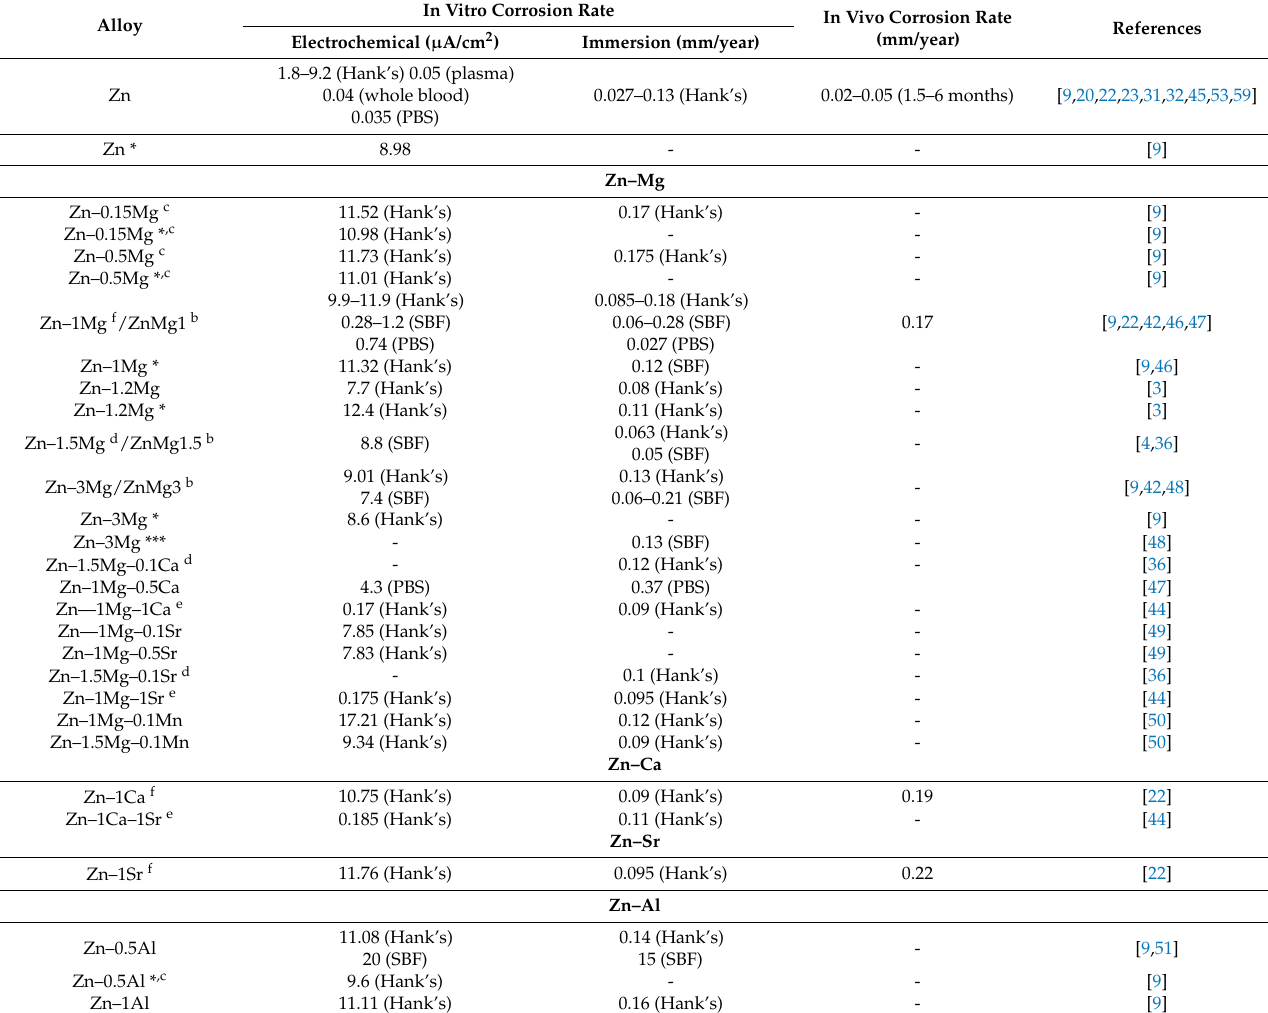
Table 4. In vitro and in vivo corrosion rates of different zinc